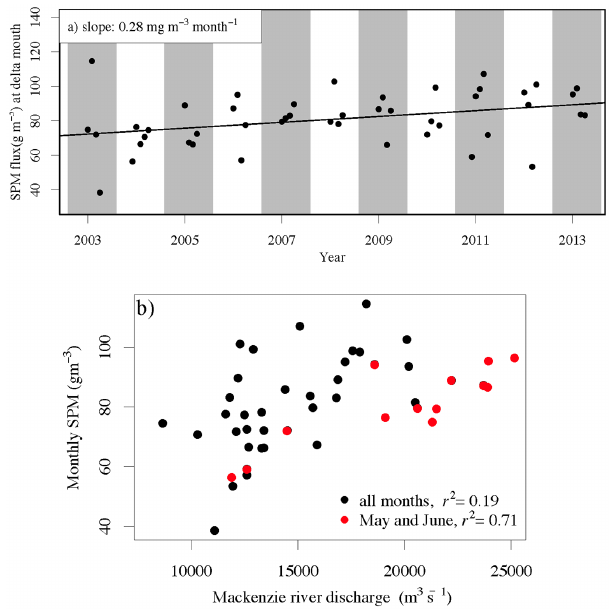
Figure 9. Multiyear (2003–2013) variations in and trend of the monthly-averaged SPM concentration at the Mackenzie River mouth (a) . Plot of the monthly-averaged SPM concentration as a function of the monthly-averaged freshwater discharge: considering all months (white circles), and then only considering the months of May and June (red circles) (b) . The determination coefficients ( R 2 ) corresponds to the best linear